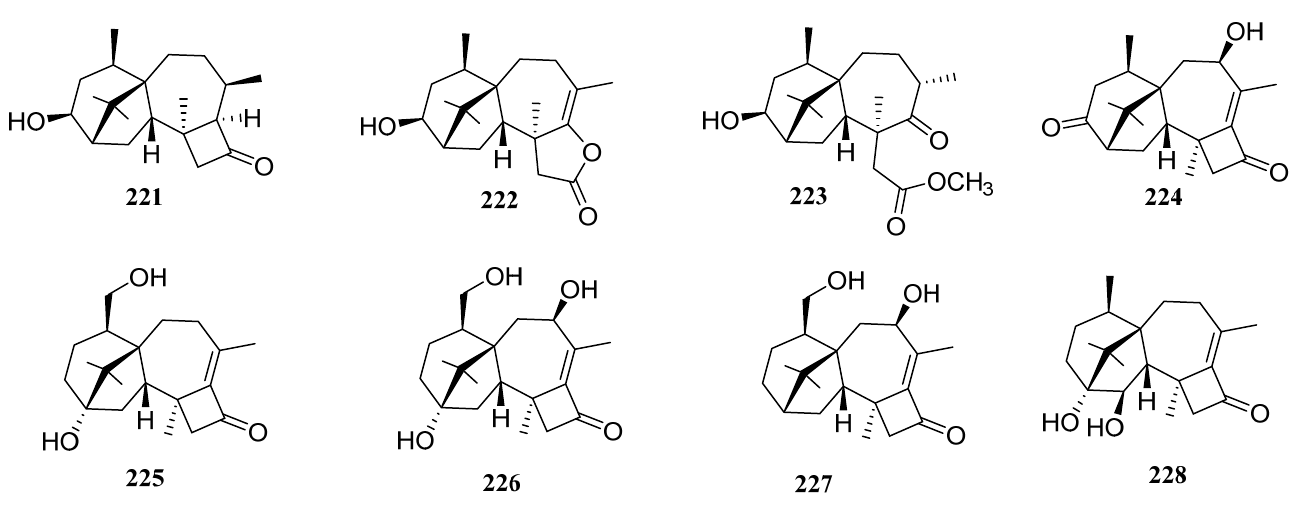
Figure 9. Chemical structures of diterpenes ( 198 – 200 from Stachybotrys sp., 201 from Talaromyces sp., 202 – 228 from Trichoderma sp.).